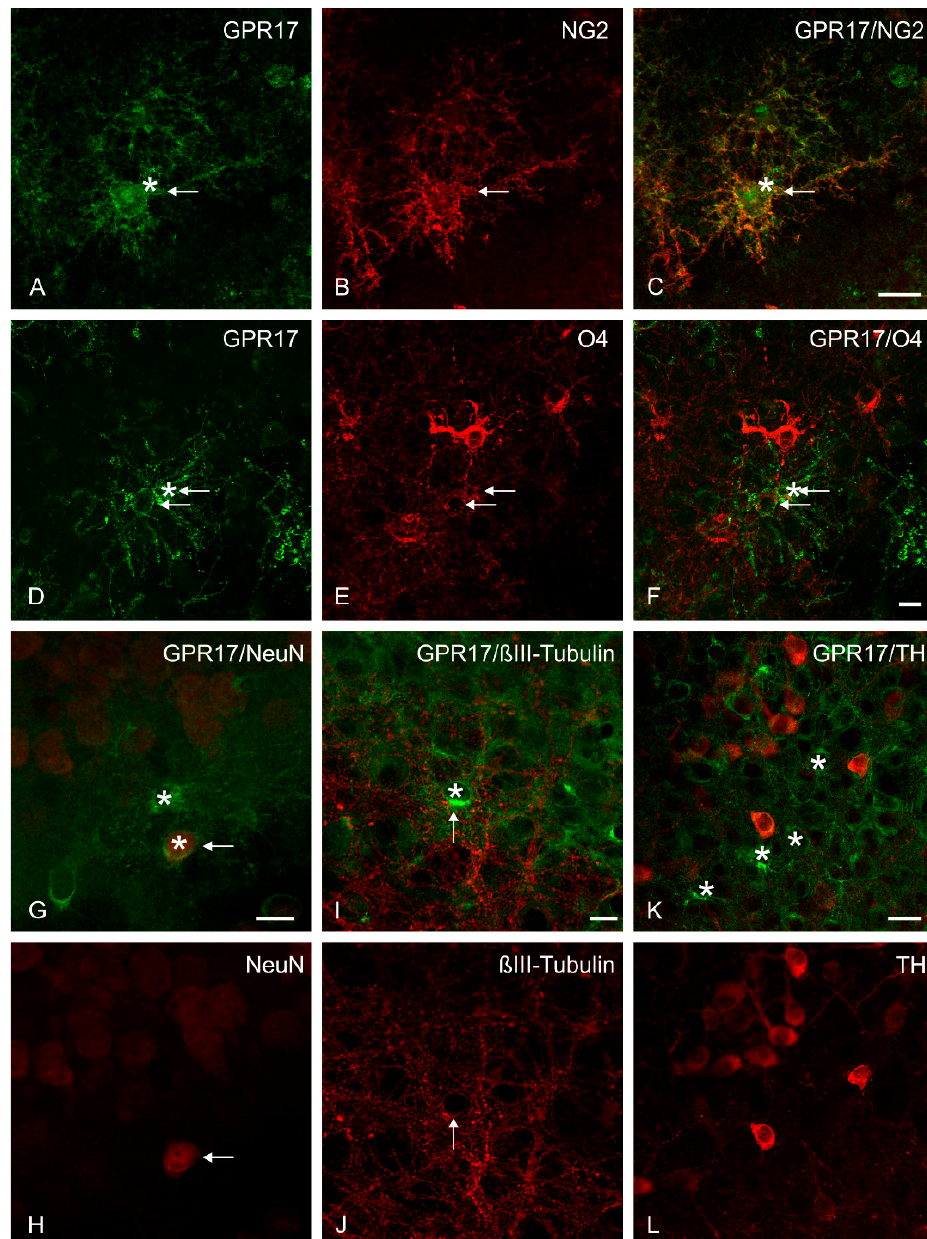
Figure 5. Multiple immunofluorescence study. Representative confocal images of GPR17 expression in organotypic slice co-cultures. At DIV 10 an intense GPR17 immunoreactivity was observed on NG2-positive cells ( A – C ) and on O4-positive cells ( D – F ). A low expression of GPR17 (stars) on a small number of cells was observed on ( G , H ) NeuN-positive cells and ( I , J ) β III-Tubulin-positive neurons (the thin arrows indicate the co-expression). No co-localization, but a number of GPR17-positive cells (stars) in the proximity were found on ( K , L ) TH-positive cells. Scale bars: A – C = 20 µm; D – J = 10 µm; K , L = 20 µm.